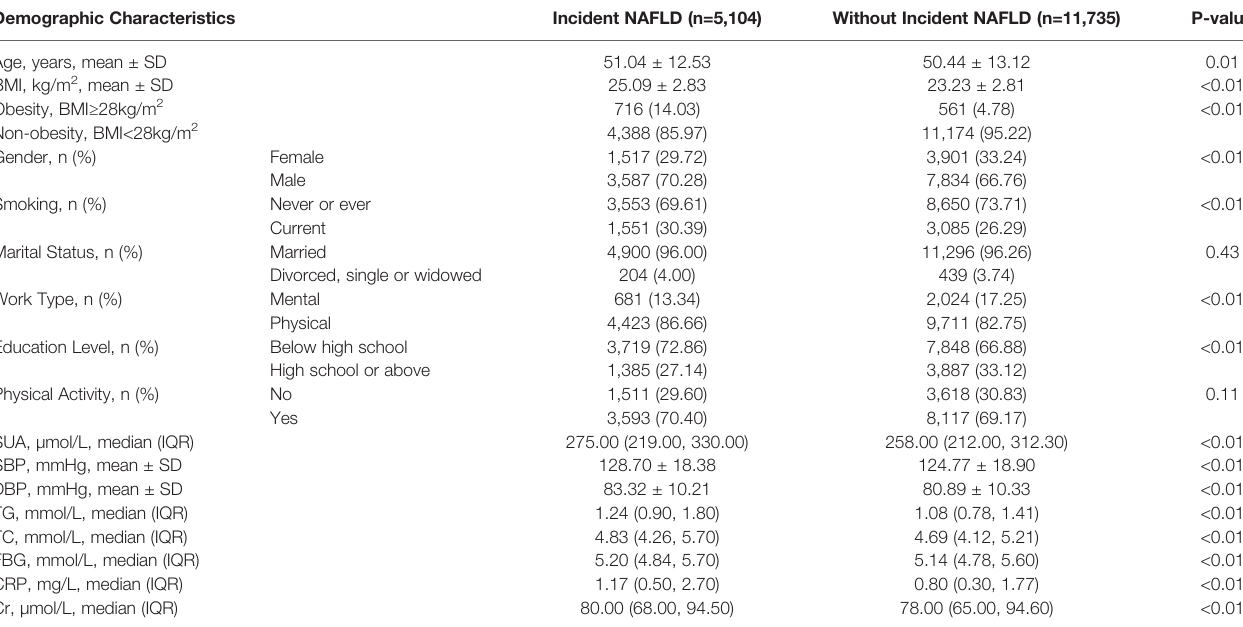
TABLE 2 | Baseline demographic and serum biomarker information of the NAFLD patients and normal participants in the Kailuan cohort study. Demographic Characteristics Incident NAFLD